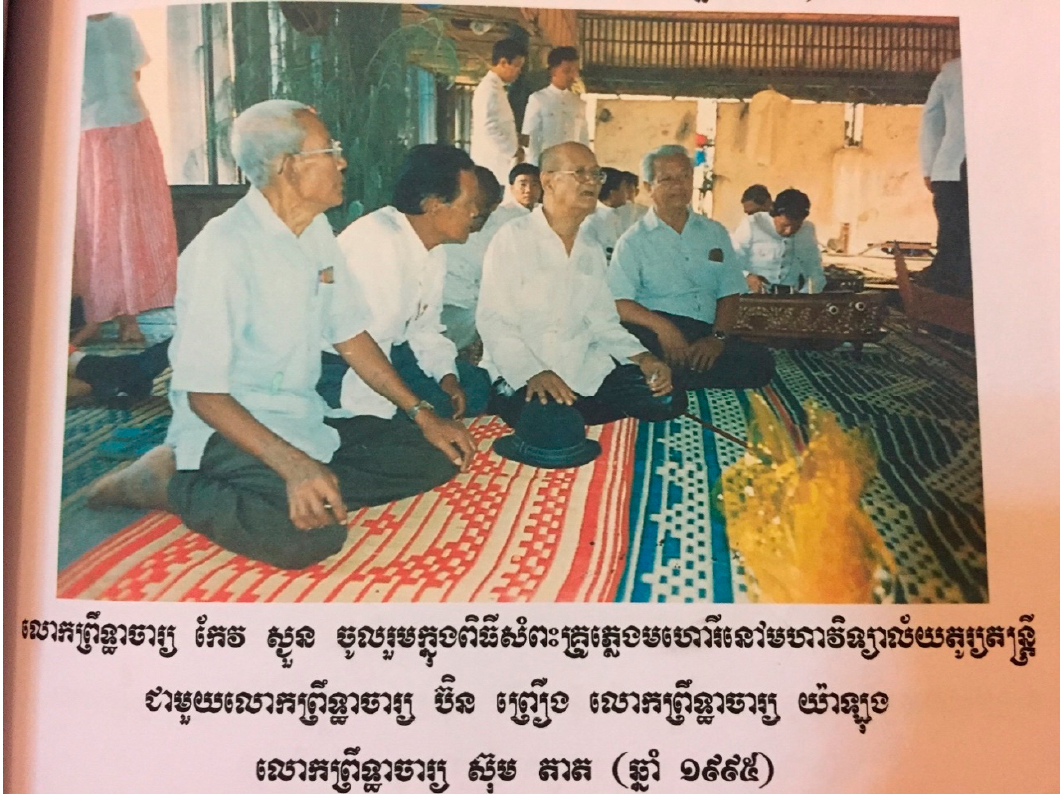
Figure 1. Keo Snguon and Ya Long: Among the musicians seated in the foreground, Keo Snguon is second from the left, leaning forward toward the man to his left, Ya Long. They are pictured at the large sa ṃ ba h ̣ gru ̄ ritual for mahaori ( mahor ī ) music conducted in 1995 at the Royal University of Fine Arts. The photograph was included in an unpublished manuscript Keo Dorivan produced about his father Keo Snguon’s life, which Keo Dorivan provided to the author.